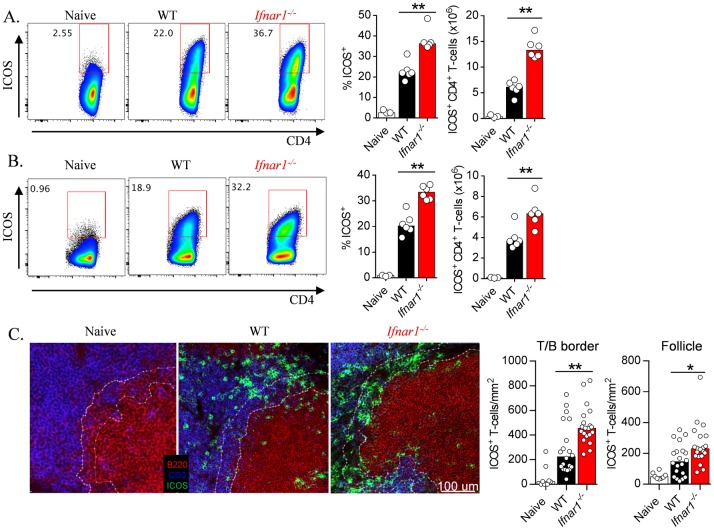
IFNAR1-signalling restricts CD4+ T-cell expression of ICOS and proximity to B cell areas of the spleen.(A) Representative FACS plots (gated on CD4+ TCRβ+ live singlets), proportions and absolute numbers of splenic ICOS+ CD4+ T-cells in naïve, and Py17XNL-infected WT and Ifnar1
-/-mice (n = 6 per group) 6 days p.i. Experiment performed once. Mann-Whitney U test **P<0.01. B) Representative FACS plots (gated on CD4+ TCRβ+ live singlets), proportions and absolute numbers of splenic ICOS+ CD4+ T-cells in naïve, and PcAS-infected WT and Ifnar1
-/-mice (n = 6 per group) 6 days p.i. Data representative of three independent experiments. Mann-Whitney U test **P<0.01. C) Representative confocal microscopy images showing spleen sections from naïve (n = 2) and PcAS-infected WT and Ifnar1
-/-mice (n = 5) on day 5 p.i., stained for ICOS (Green), CD3 (Blue), and B220 (Red). T-B borders are outlined by white dotted lines. Summary graphs illustrate ICOS+ CD3+ cell densities for individual T/B borders and B cell follicles, with data pooled from four T-B borders or follicles per mouse, (n = 2 for naïve and n = 5 for WT and Ifnar1
-/- mice). Scale bar: 100μm. Mann-Whitney U test *P<0.05; **P<0.01.